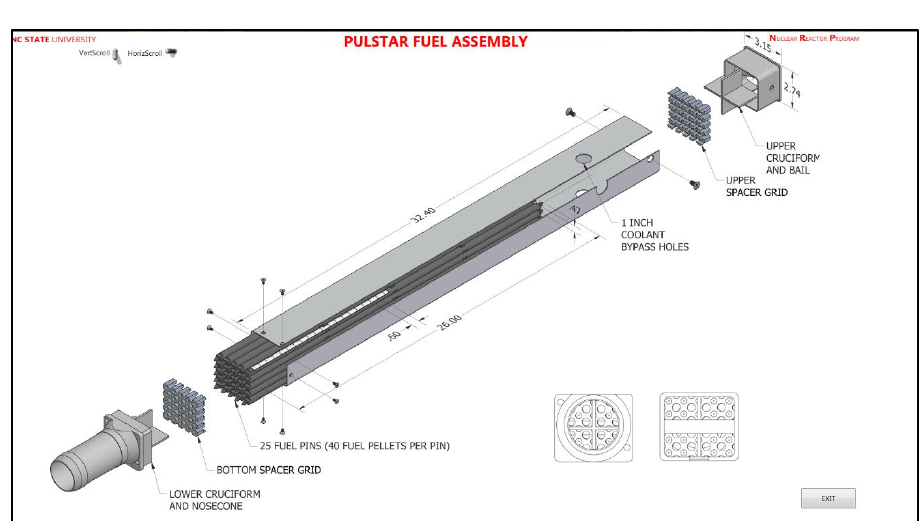
Fig. 6. Diagram of PULSTAR fuel assembly.